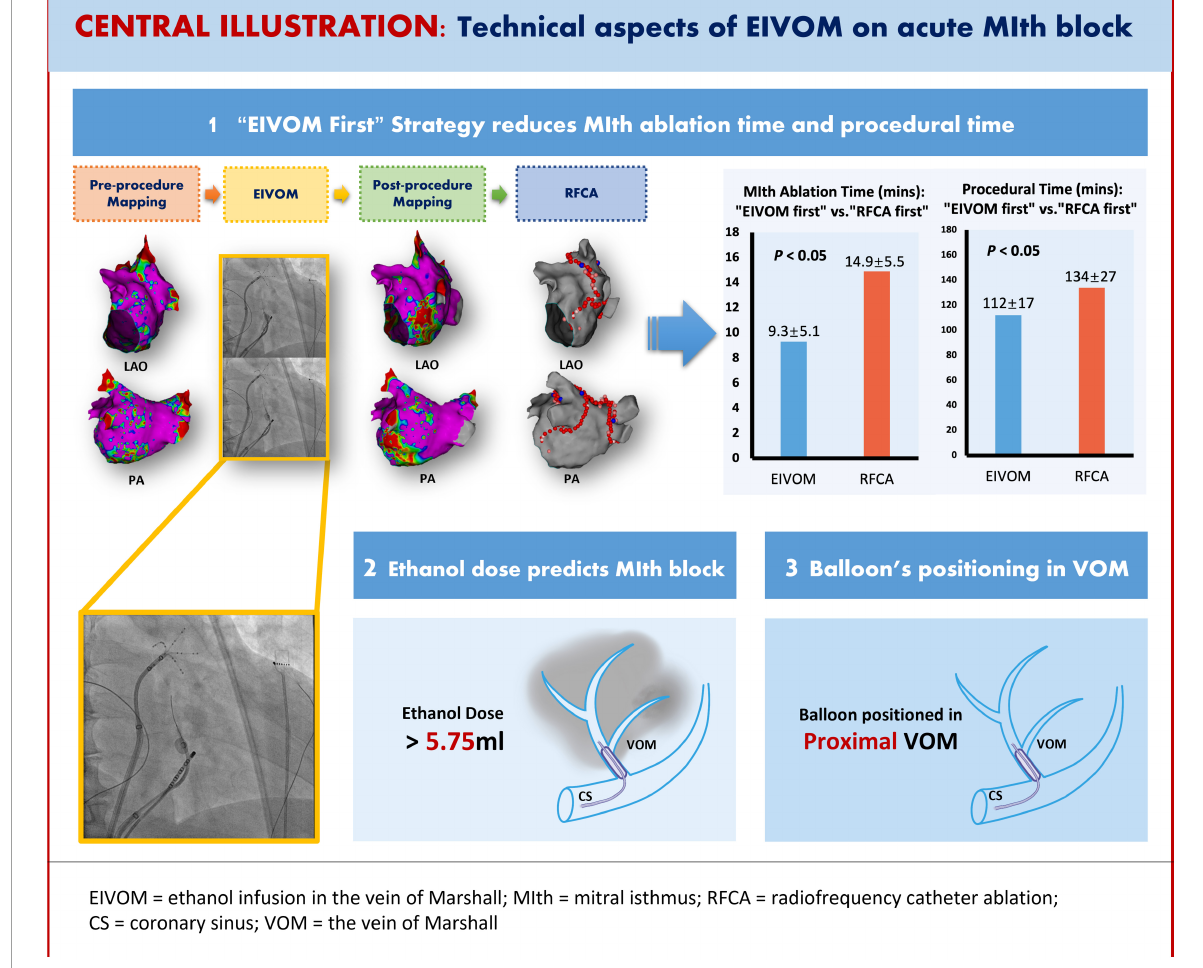
FIGURE6 Central illustration: Technical aspects of EIVOM on acute MIth